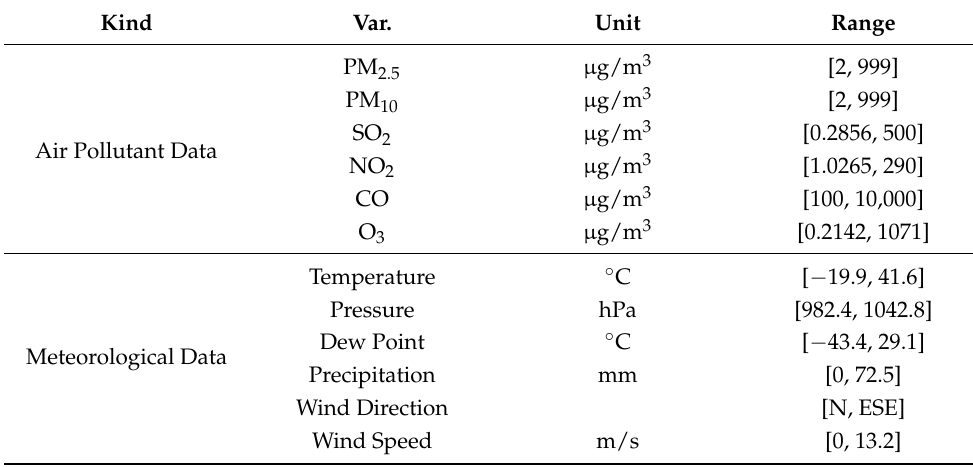
Table 1. Input variables for PM 2.5 concentration forecasting